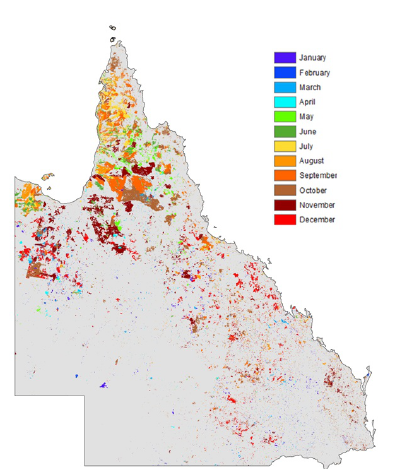
Figure 5. Example of Landsat fire scar mapping in Queensland. This example shows all fire scars mapped for the year 2001.